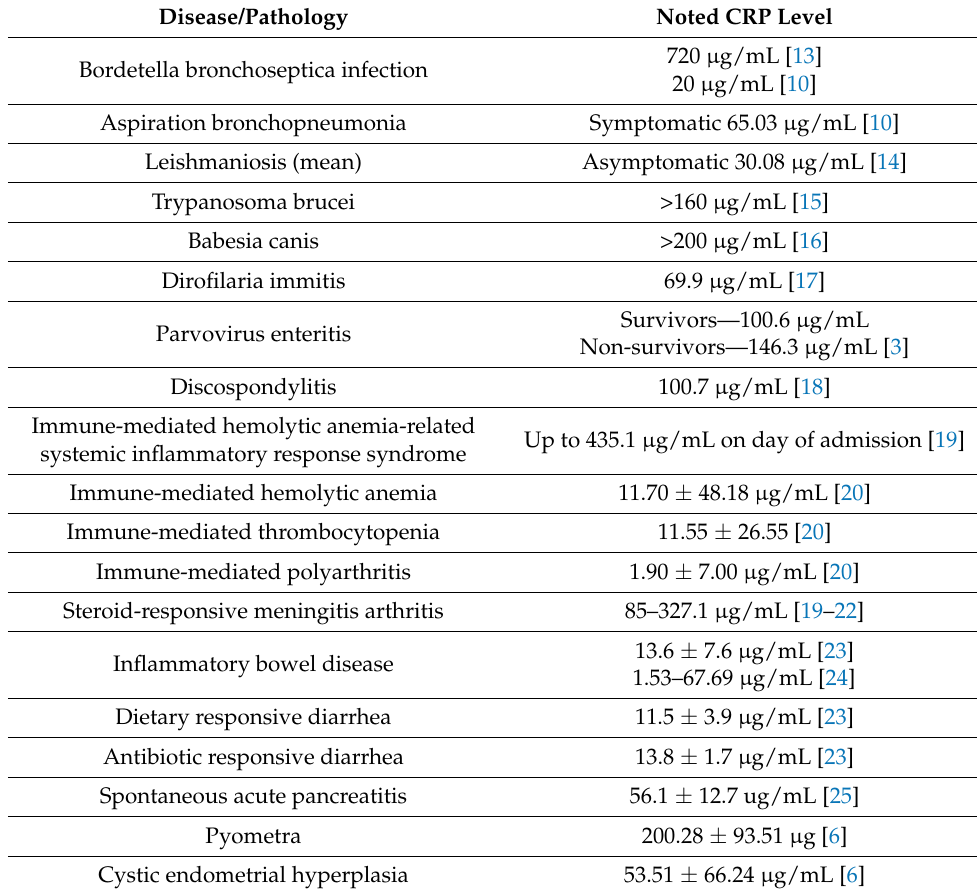
Table 1. CRP concentration values have been recorded in various studies.